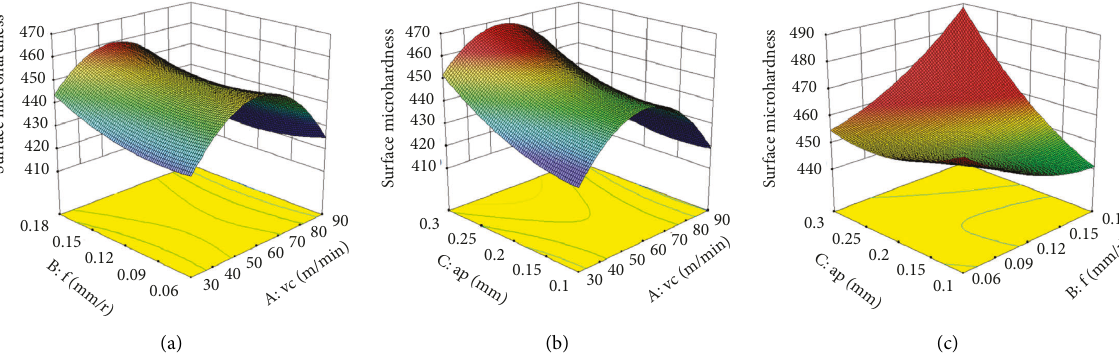
Figure 4: The influence of cutting parameters on HV . (a) The influence of f and v influence of a p and f on HV